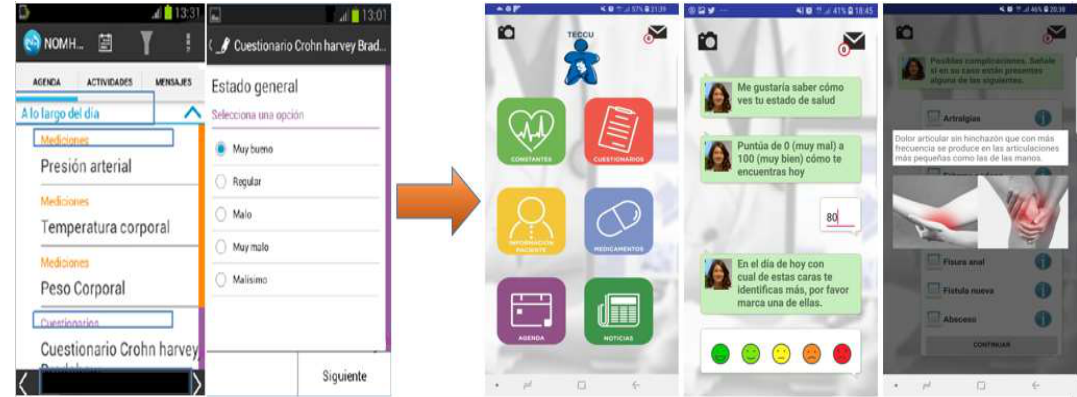
Figure 3. Adaptations to the TECCU platform design to improve usability.